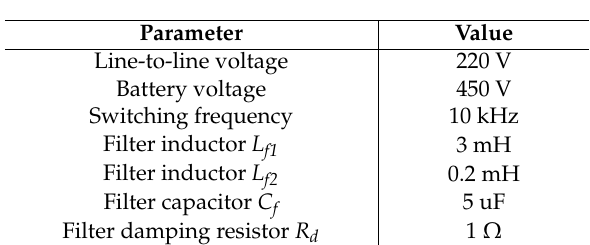
Table 1. Circuit parameters for stand-alone power